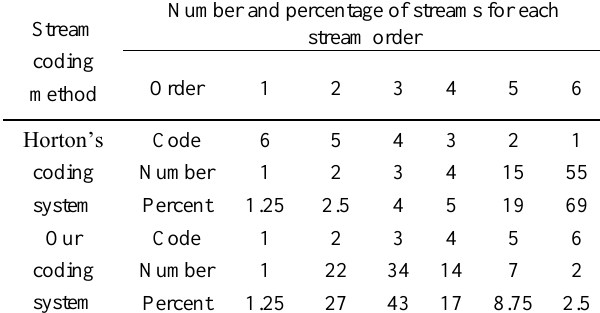
Table 1 Comparison between two hydrologic coding systems in terms of the number of streams corresponding to each stream order A histogram was plotted using the data in Table 1 to provide an intuitive description of the distribution of stream numbers for each stream order (Fig. 6).